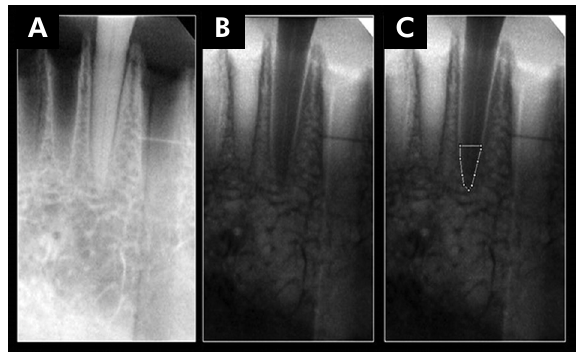
Figure 1. A) Original image, B) inverted image and C) the re- gion of interest (ROI) defined manually using ImageJ